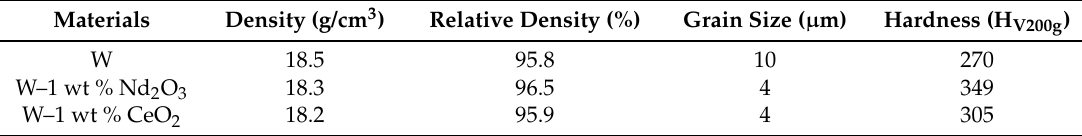
Table 1. Density, grain size, and Vickers microhardness ( H V200g ) of pure W, W–1 wt % Nd 2 O 3 , and